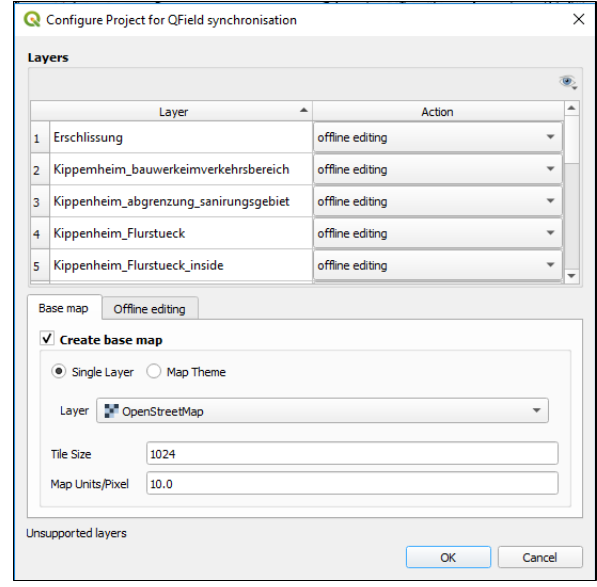
Figure 4: QField plugin configuration in QGIS.